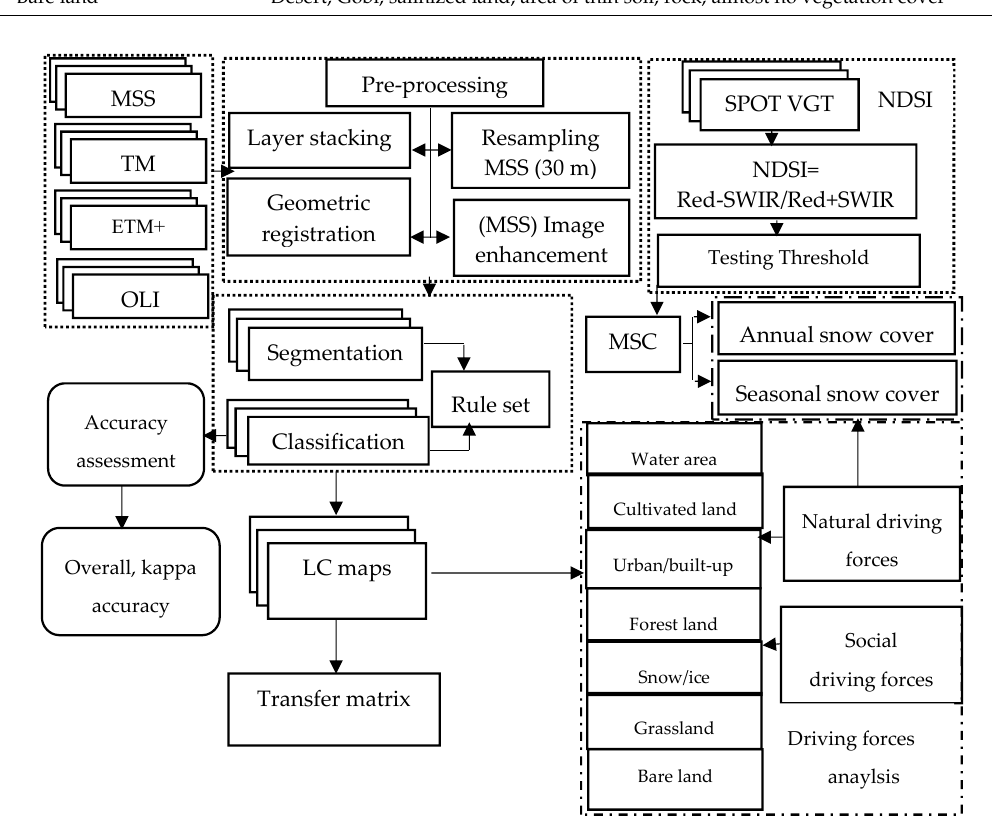
Figure 2. Flow chart of methodology.